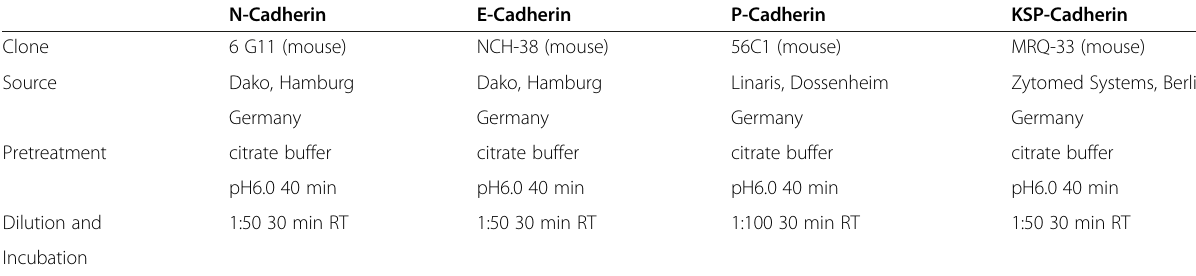
Table 2 Applied antibodies and conditions for primary immunohistochemical reaction